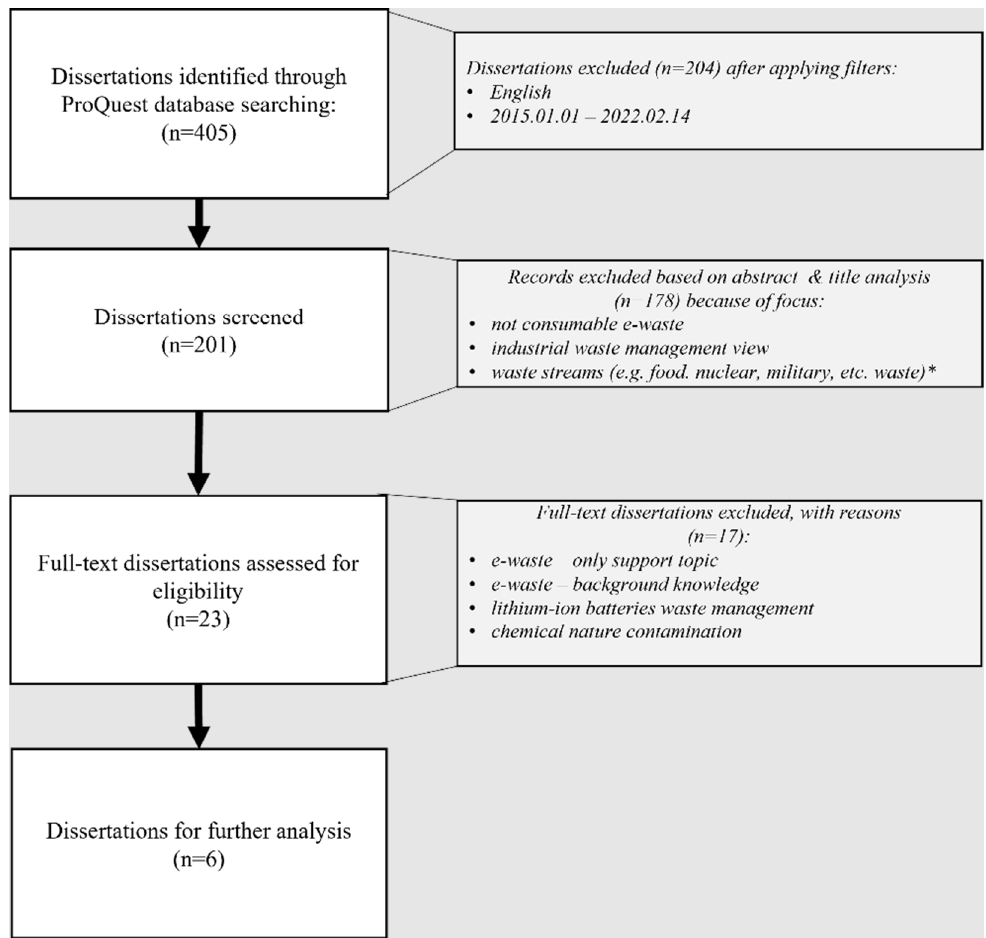
Figure 2. PRISMA study flow diagram synthesized from [97,99]. Table 3. Examples of words that were not in the core focus of this study (consumable e-waste) and not considered in the screening phase of